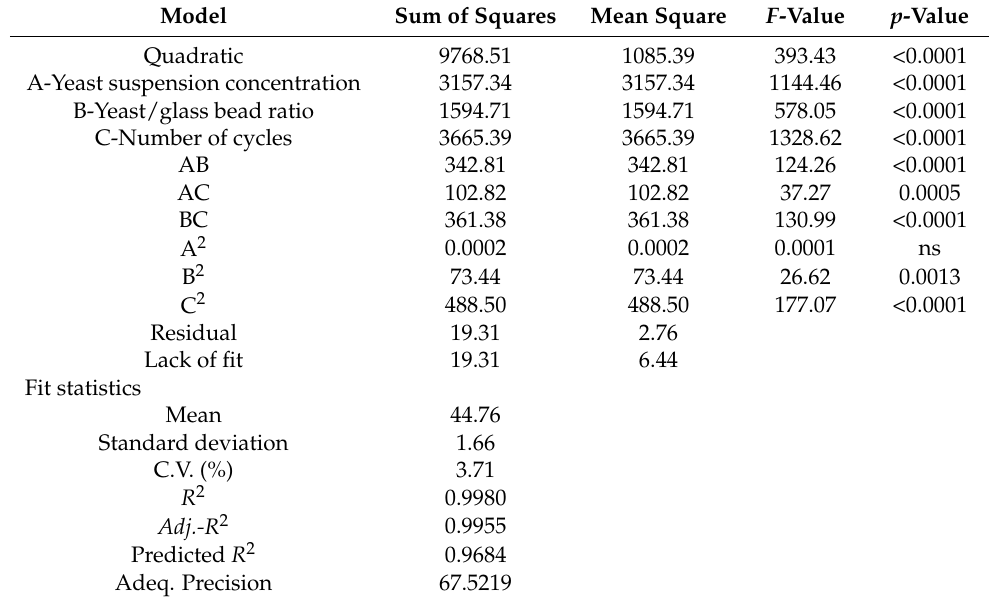
Table 3. ANOVA results for the effects of factors on cell disruption